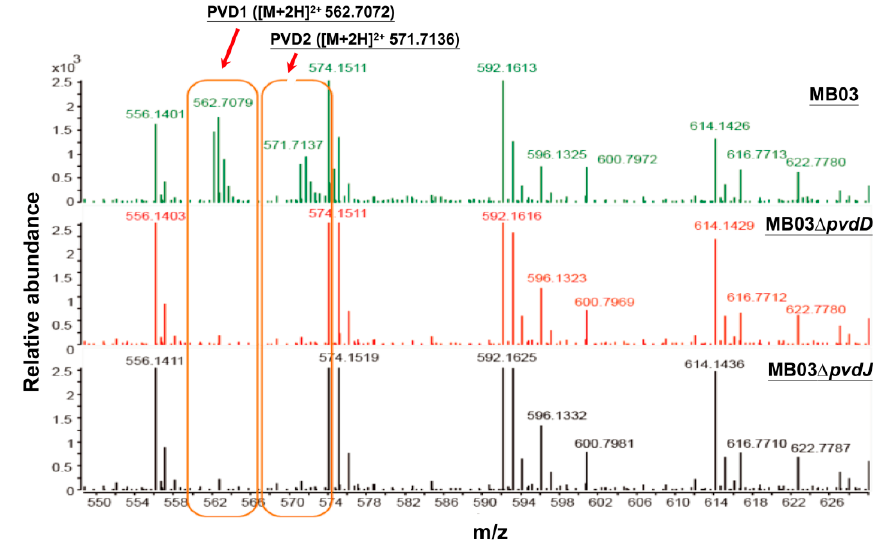
Figure 4. Liquid chromatography-mass spectrometry (LC-MS) analysis of cell free filtrates of MB03, MB03 ∆ pvdD , and MB03 ∆ pvdJ : MB03 and its derivatives were grown in M9 media for 48 h.